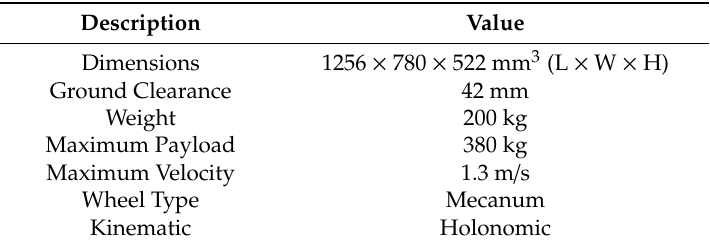
Table 1. Technical data of the mobile